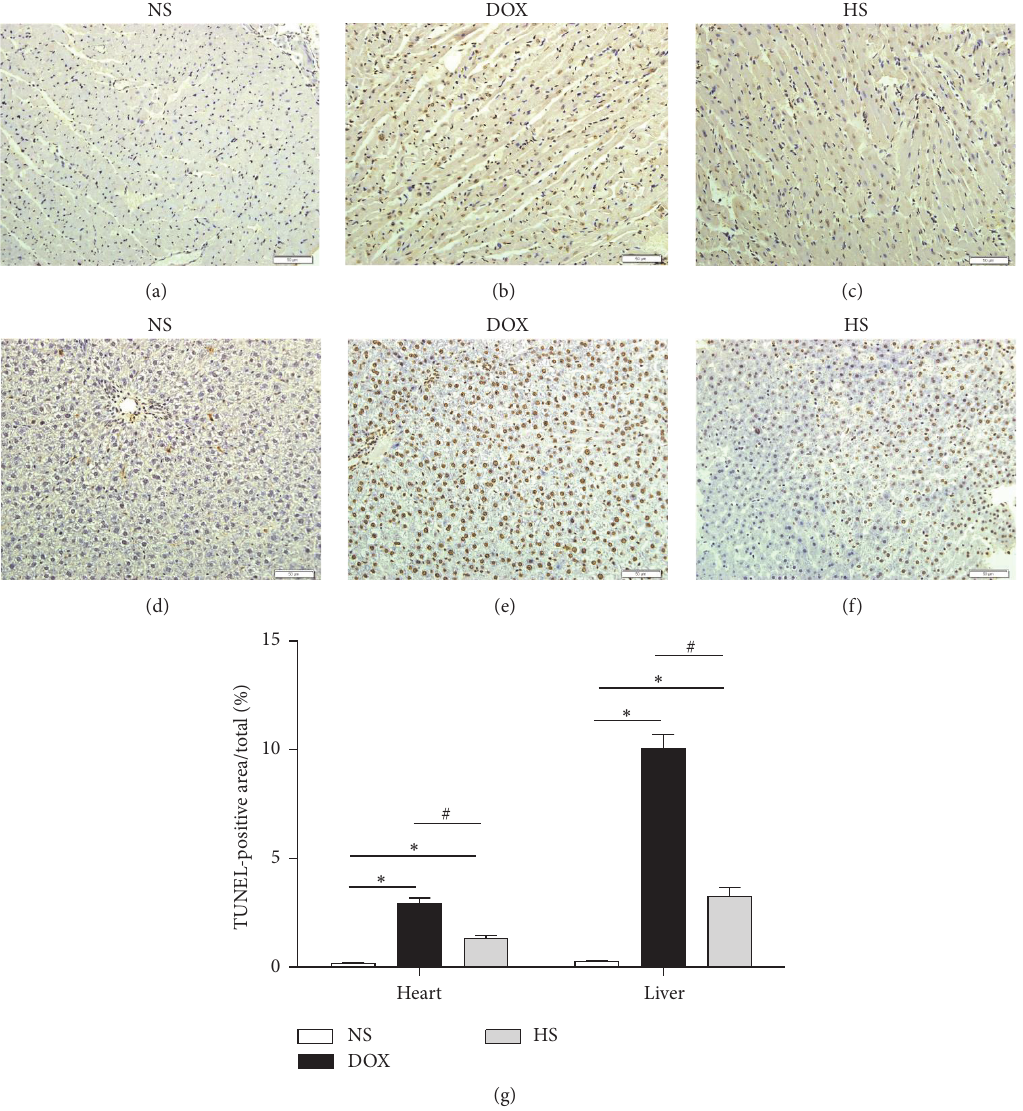
Figure 6: The antiapoptosis of hydrogen-rich saline on cardiac and hepatic tissue in TUNEL staining. Heart (200x magnification; (a–c)) and liver (200x magnification; (d–f)) sections of different treatment groups were stained by TUNEL, and the percentage of TUNEL-positive area (brown staining) of cardiac and hepatic (g) tissues was calculated for each group. Data are shown as mean ± SD. ∗ 𝑃 < 0.05 versus NS group; # 𝑃 < 0.05 versus DOX